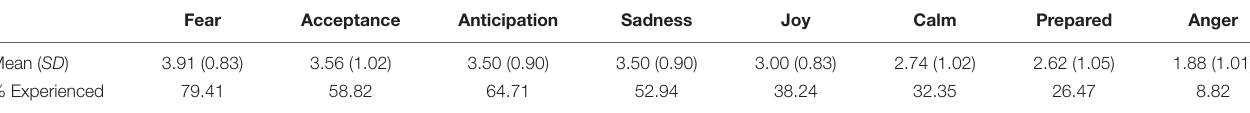
TABLE 1 | Participants’ emotions regarding the transition out of university (rated from 1 to